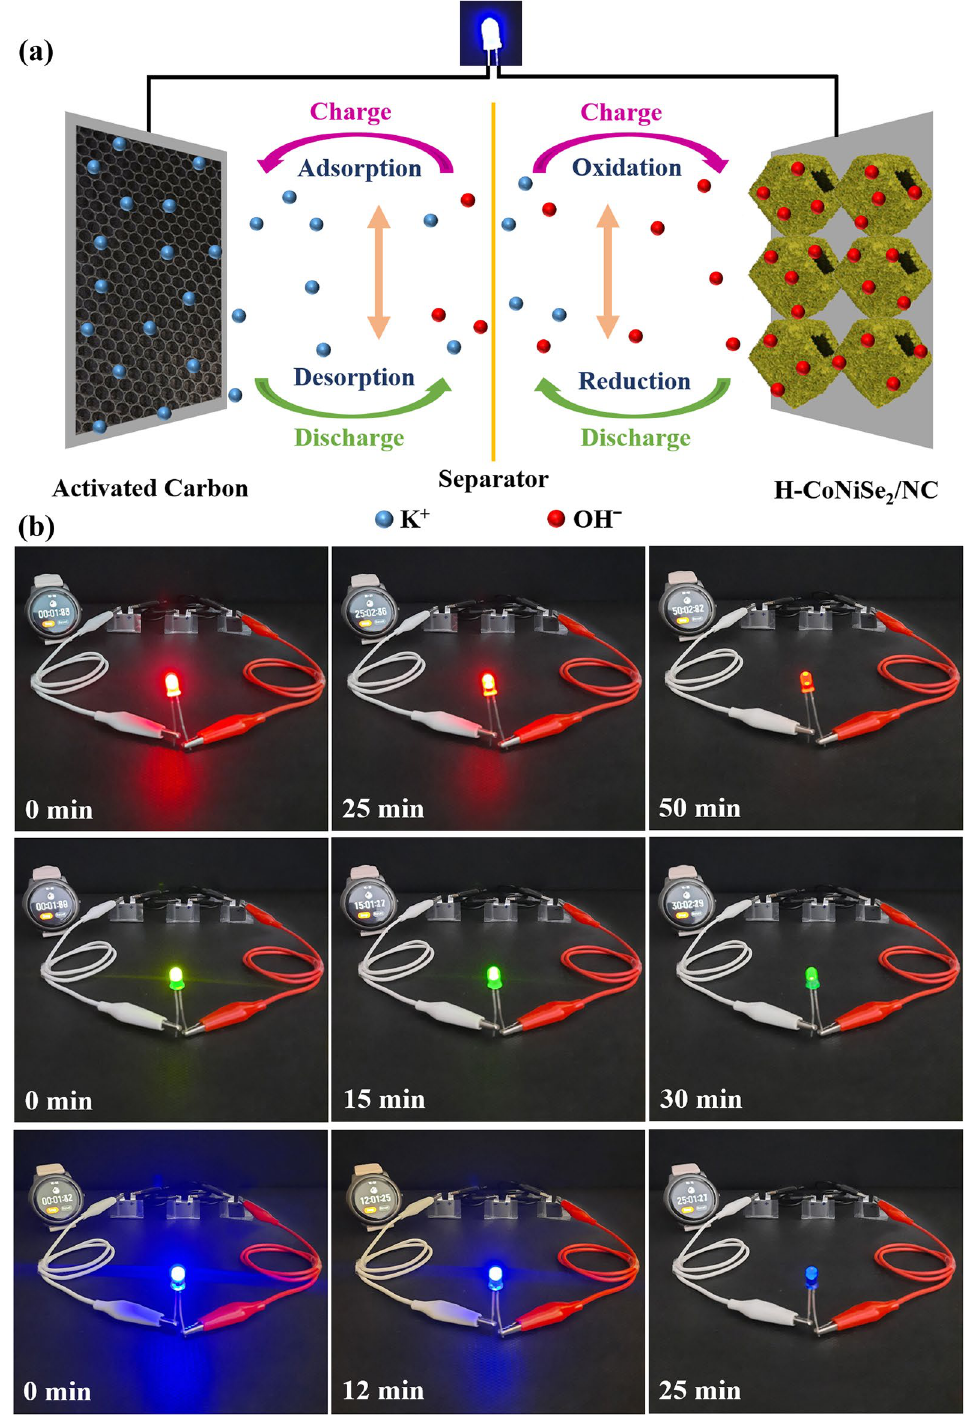
Figure 8. ( a ) Schematic illustration of the H-CoNiSe 2 /NC//AC asymmetric supercapacitor. ( b ) Photographs of red, green, and blue LEDs powered by three H-CoNiSe 2 /NC//AC in